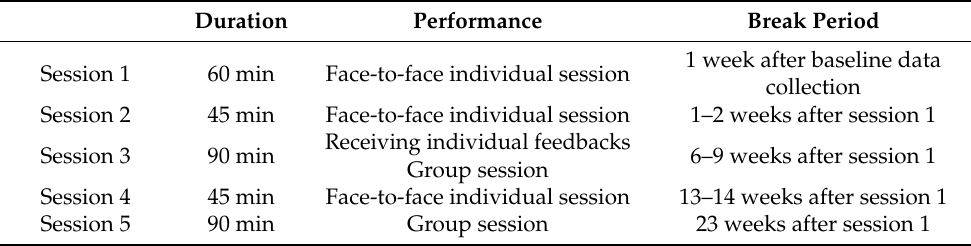
Table 1. Motivational counselling sessions during intervention